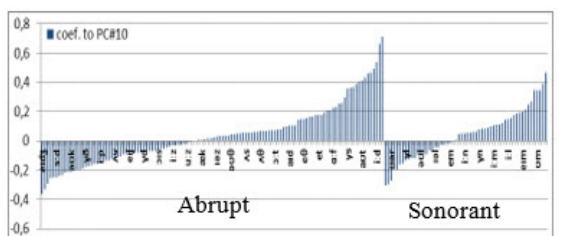
Figure 7. Plot of the influence of the VC-biphones on the valence-correlated PC, expressed by means of their coefficients in the component transition matrix. It can be seen in Table 3 that the VC-bi- phones /eɪp/ and /yk/ (/Ik/), positively project - ed on the valence-correlated PC, are between the listed in Table 2 VC-biphones which, even in the small amount of textual data used in the experiment, displayed, each of them separate- ly, a reliable positive correlation with valence. As indicated by the extracted metadata, Table 3, the vowel /eɪ/ appears in the abrupt /eɪp/and in the sonorant /eɪm/